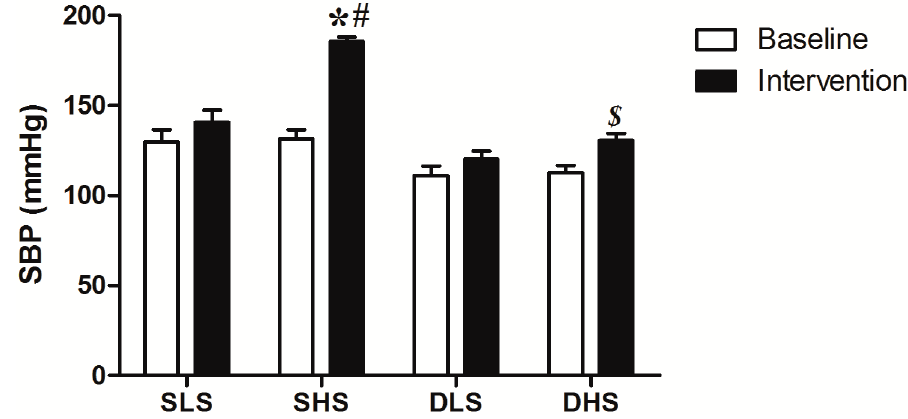
Figure 1. Systolic blood pressure (SBP) of rats before and after salt intervention. SLS (salt-sensitive low salt); SHS (salt-sensitive high salt); DLS (Sprague-Dawley low salt); DHS (Sprague-Dawley high salt). * p < 0.01 vs. SLS intervention; # p < 0.01 vs. DHS intervention; $ p < 0.01 vs. DLS intervention.